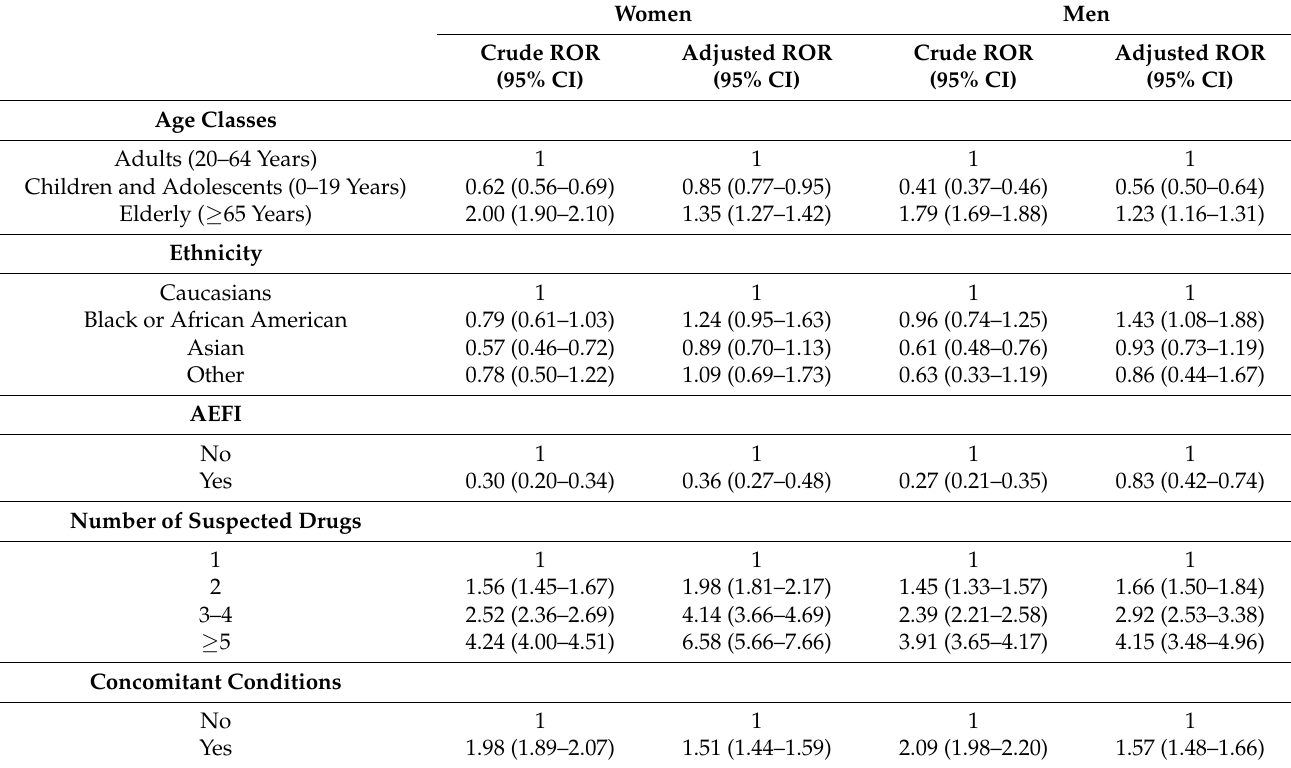
Table 3. Predictors of hospitalization among women and men expressed as reporting odds